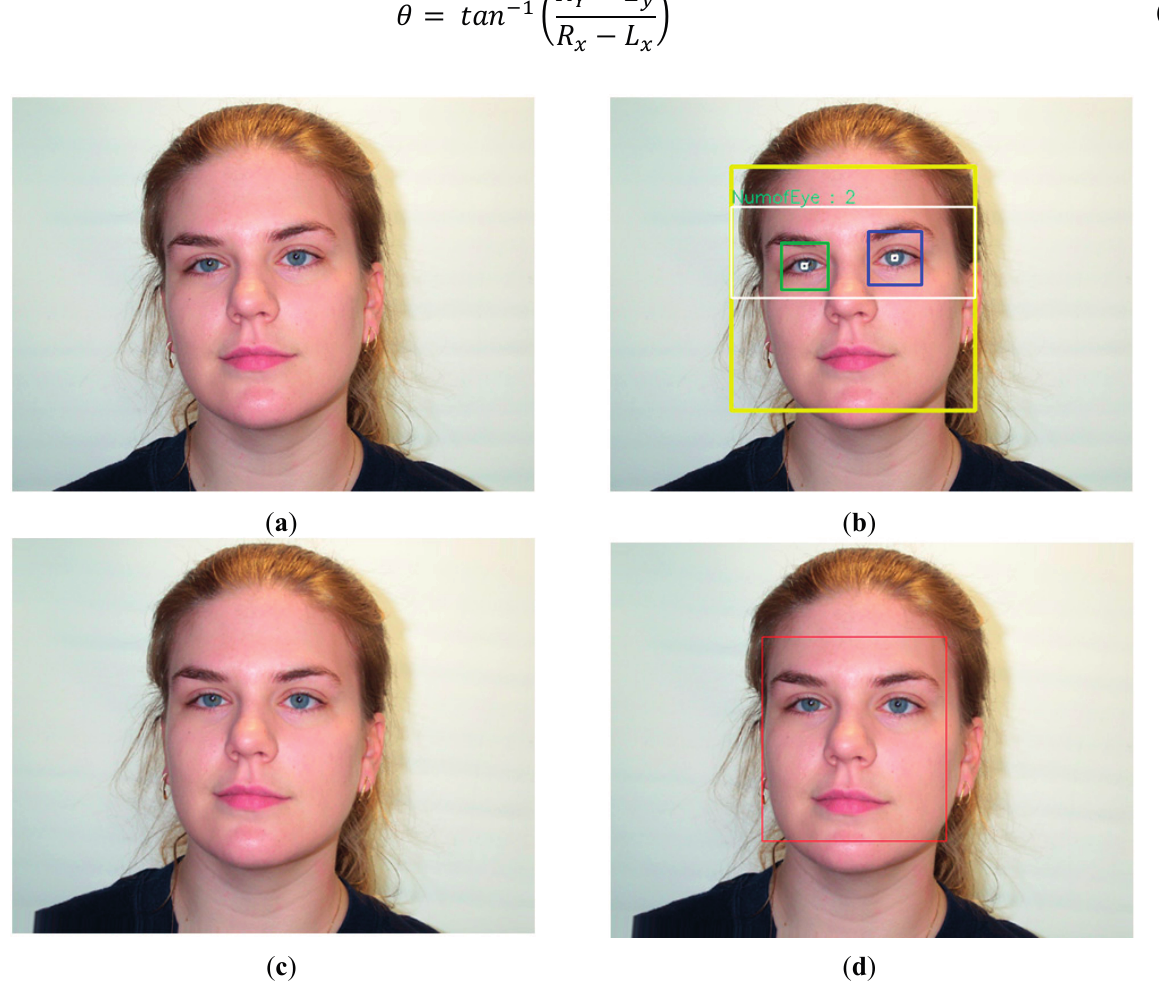
Figure 2. Demonstration of in-plane rotation compensation and face region redefinition in our method: ( a ) input facial image; ( b ) detection results of face and eyes using Adaboost method; ( c ) in-plane rotation compensation; and ( d ) redefinition of face